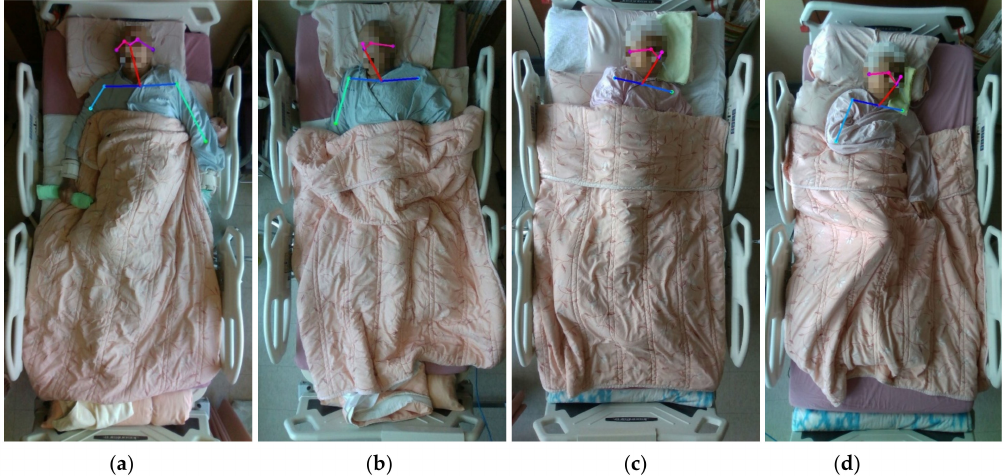
Figure 6. Successful cases in clinics: ( a , b ) cases 1 and 2 for the male patient, ( c , d ) cases 1 and 2 for the female